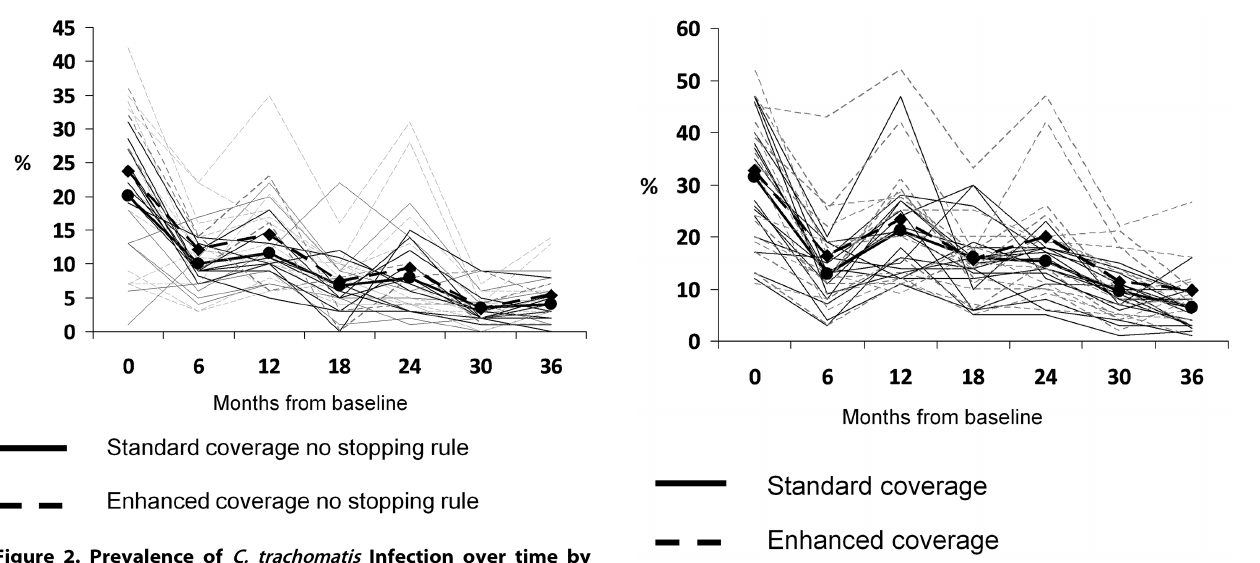
Table 3. Impact of enhanced target coverage on prevalence* of C. trachomatis infection and follicular trachoma at 36 months.